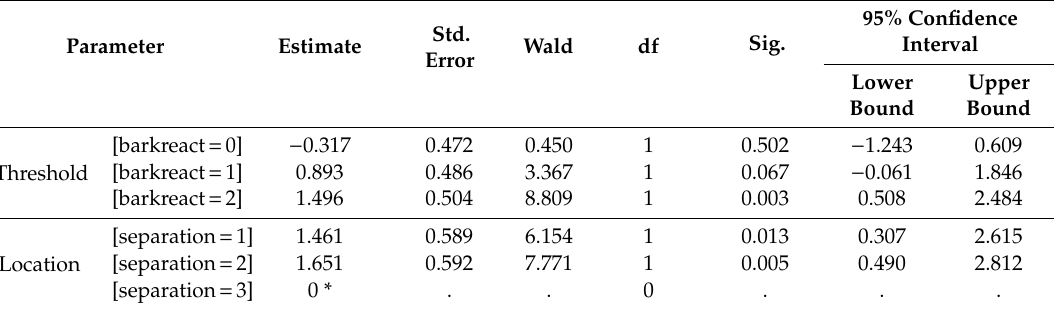
Table 2. Parameter estimates of the puppies’ reaction to other dogs’ barking as a function of the method of housing of the puppies (ordinal regression). “Barkreact” 0–2 levels show an increasing intensity of fearful / joining reaction when other dogs bark. “Separation” 1–3 levels show a decreasing extent of separating the puppies from the other dogs during the time spent at the breeder’s house. * this parameter is set to 0 because it is